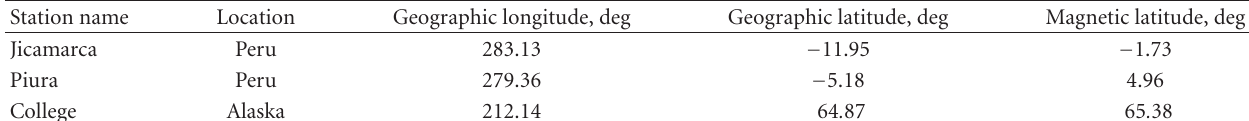
Table 1: Magnetometer stations.